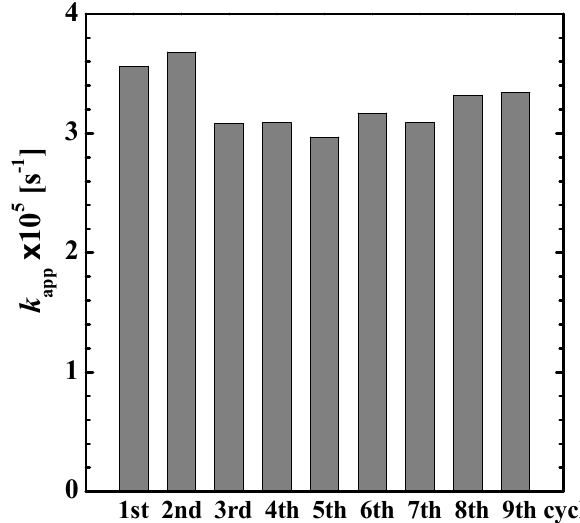
Figure 6. Value of k app in the repeated reaction cycles of the degradation of 4-isopropylphenol photocatalyzed by the TiO 2 nanoparticle-loaded fiber at 50 °C.